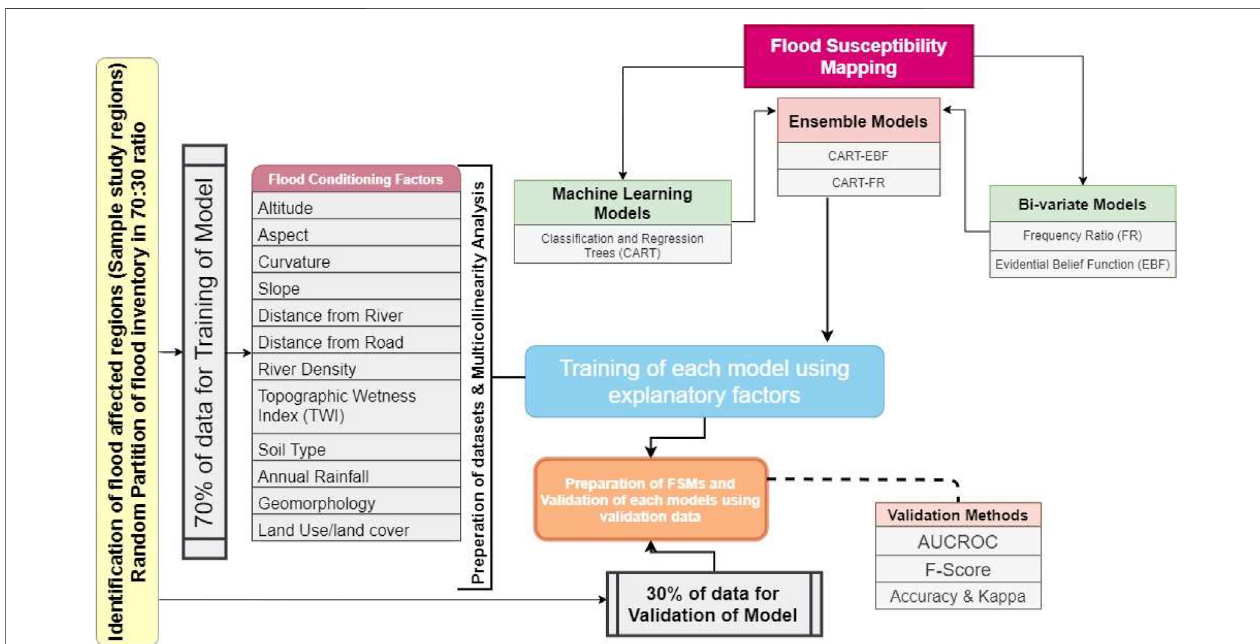
FIGURE 2 | Flow diagram showing step-by-step methodology employed in this